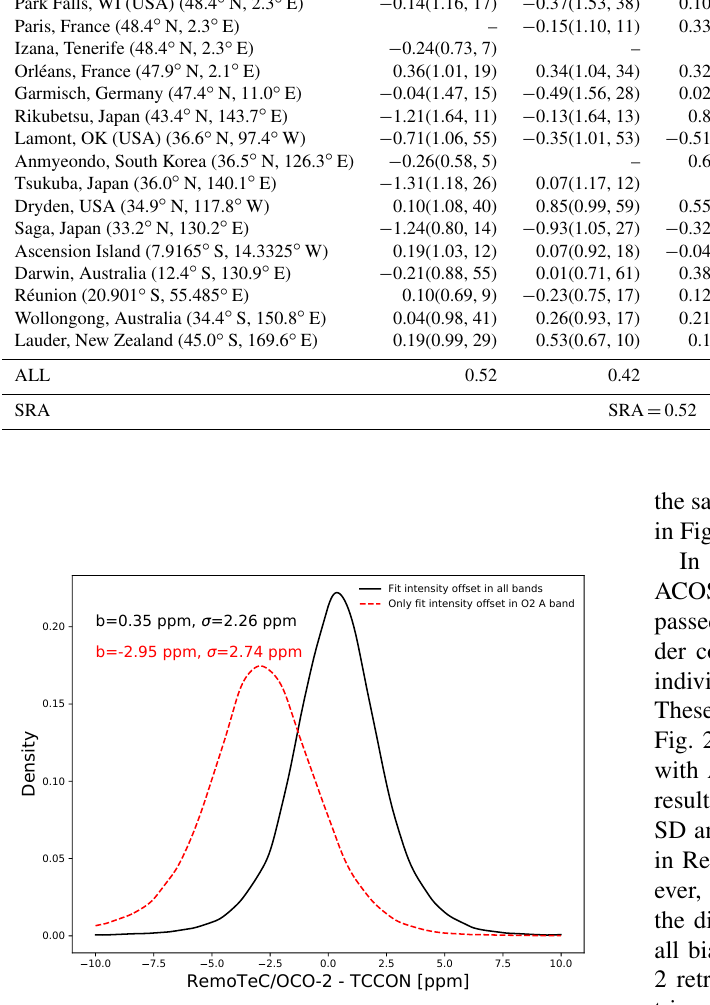
Figure 12. Density distributions of the X CO differences between 2 OCO-2 land retrievals and collocated TCCON data for two differ- ent retrieval settings. In the black solid line we fit intensity offsets in all three OCO-2 bands while in the red dashed line we only fit the intensity offset in O 2 A band. Here we only do algorithm con- vergence filtering for both and take the intersection of them for fair comparison. The bias b and sounding precision σ for each retrieval are